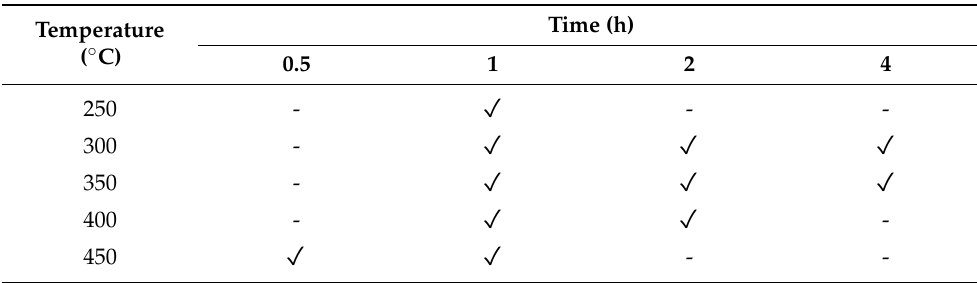
Table 2. Heat treatment temperature/time couples applied to the heat treatment of electroless nickel-boron coatings.